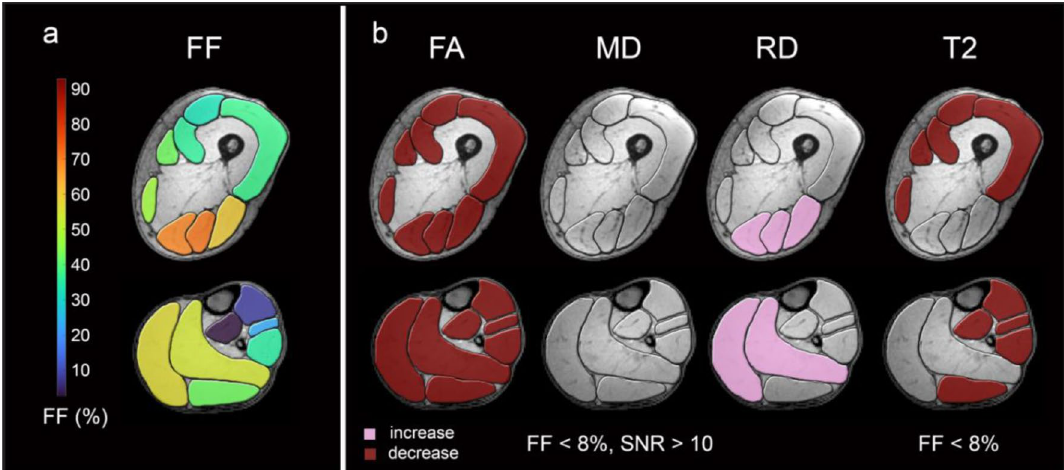
Figure 3. qMRI data in low-fat muscles. Overview of mean fat fractions of all LGMD patients in thigh and calf muscles ( a ). High-risk muscles are coloured in yellow and orange, intermediate-risk muscles are coloured in green and low-risk muscles are coloured in blue. Muscle groups with significant differences of FA and MD in muscles with FF < 8% and SNR > 10 and T2 in muscle groups with FF < 8% between study groups are coloured in red ( b ) (increase/decrease in patient group: burgundy / pink).